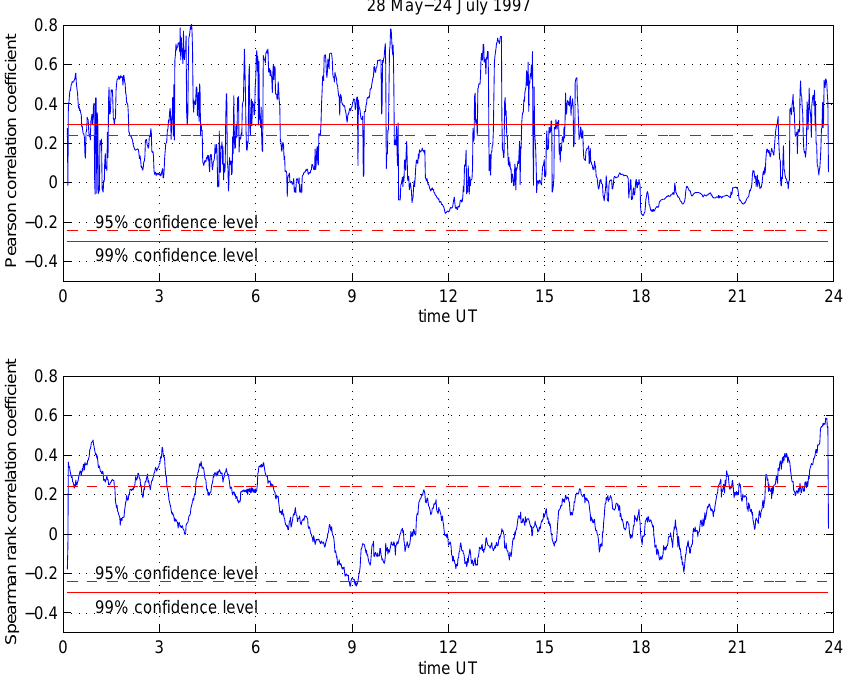
Fig. 4. Pearson correlation coefficient and Spearman rank correlation coefficient computed for day-to-day variations for each 1-minUT time interval over the day. Calculations are based on the square of absorption and linear signal-to-noise ratio data taken over all the observation days for each particular time